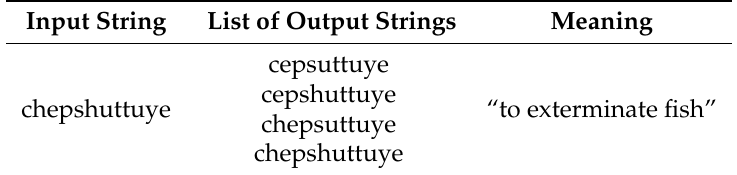
Table 2. A fragment of text before and after processing with the normalization algorithm.